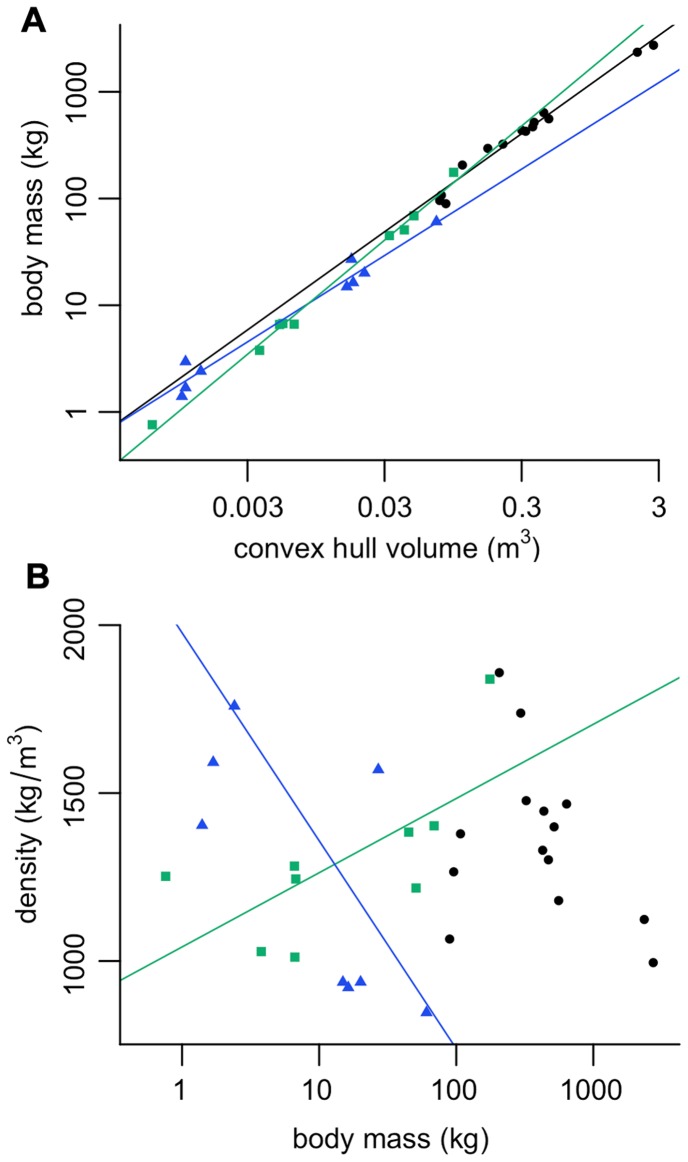
OLS regression results.A, Body mass (kg) against convex hull volume (m3). For slope equations, see Table 2 (labelled in bold). B, apparent density of convex hull (kg/m3) against body mass (kg). Density did not scale with body mass in non-primate mammals. Density increases with body mass in primates (a = 1042, b = 221, r
2 = 0.46, p = 0.025) yet decreases with body mass in birds (a = 1977, b = −619, r
2 = 0.36, p<0.05). Black circles, non-primate mammals; green squares, primates; blue triangles, birds.